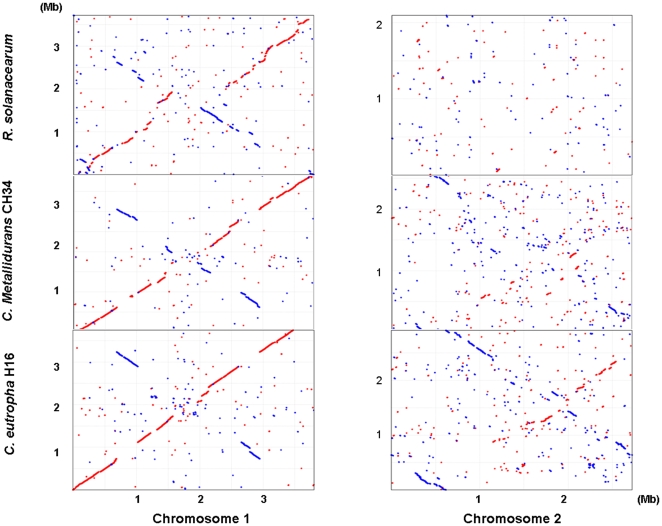
Synteny plots between C. necator JMP134 (horizontal axis) and C. eutropha H16, C. metallidurans CH34, and R. solanacearum GMI1000.Red  =  leading strand; blue  =  lagging strand.